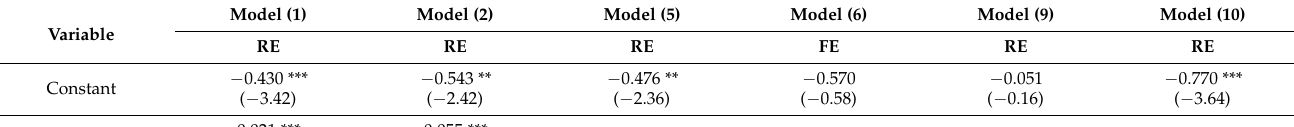
Table 10. Robustness check results of Models (1), (2), (5), (6), (9), and (10).